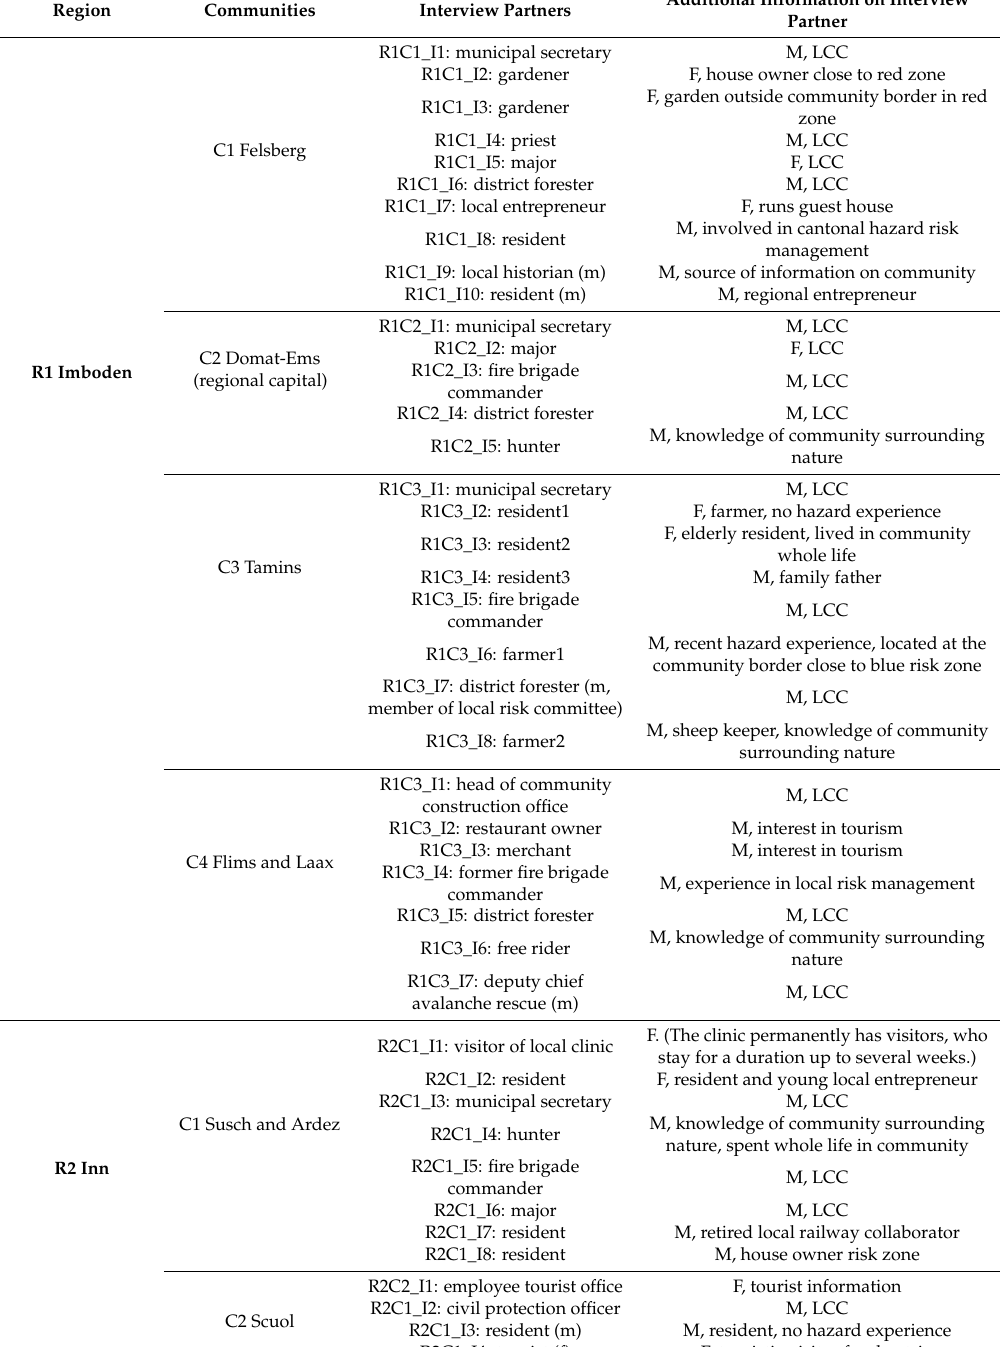
Table 1. Overview case study